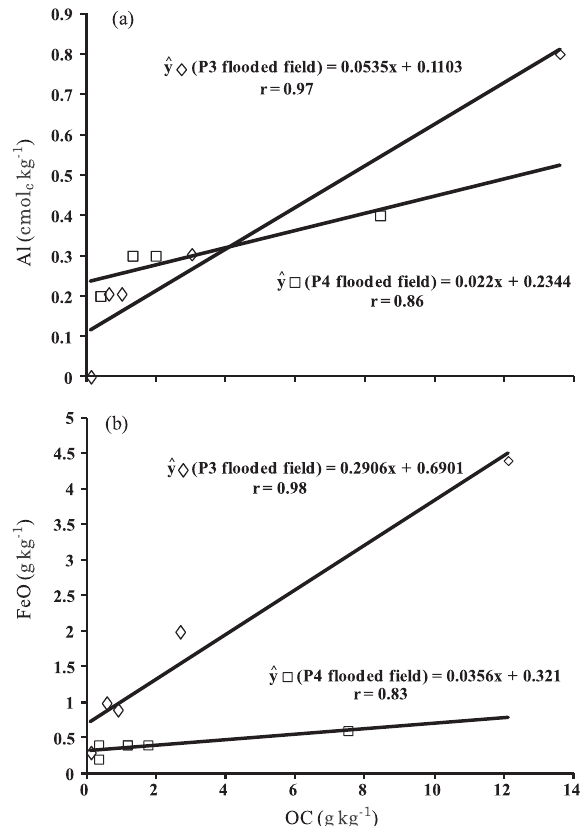
figure 3. Pearson correlation between carbon and aluminium (a). P3 (p = 0.0027), P4 (p = 0.0134); and between carbon and iron oxalate (b). P3 (p = 0.0018), P4 (p =